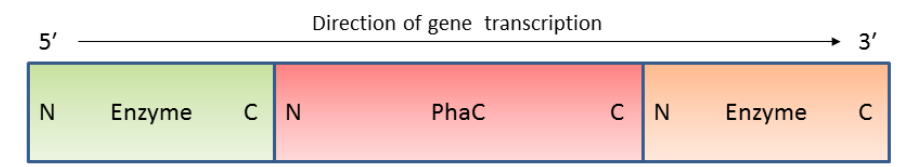
Figure 1. Potential sites of enzyme attachment utilising gene fusions to PHA synthase. N,N-terminus;